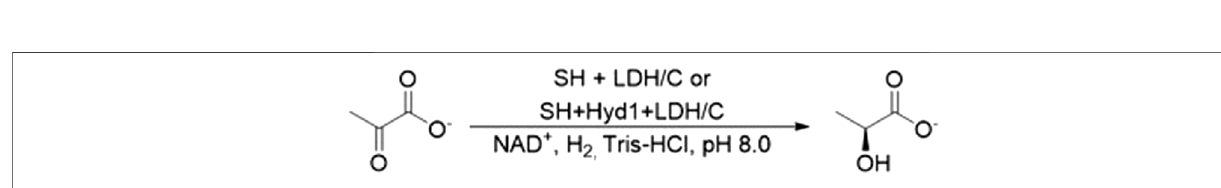
FIGURE 6 | NADH generation by SH/C or SH + Hyd1/C under continuous fl ow hydrogenation conditions. The left y axis shows the cumulative amount of product formed, and the right y axis shows the TTN of the NAD + reductase module of the SH. (A) Lifetime performance of SH/C [SH (0.18 mg), activated charcoal (20 mg)] vs. SH + Hyd1/C [SH (0.18 mg), Hyd1 (0.2 mg), activated charcoal (20 mg)] for the conversion of NAD + to NADH in the hydrogenation fl ow reactor. Reaction conditions: NAD + (5 mM), Tris-HCl buffer (50 mM, pH 8.0), 30 ° C, liquid fl ow rate (cid:1) 0.05 ml min − 1 , H 2 fl ow rate (cid:1) 0.6 ml min − 1 , t Res (cid:1) 18 s, reactor volume (cid:1) 0.2 ml. (B) The effect of temperature on the lifetime performance of SH + Hyd1/C [SH (0.18 mg), Hyd1 (0.2 mg), activated charcoal (20 mg)] for the conversion of NAD + to NADH in the fl ow reactor. Reaction conditions: NAD + (5 mM), Tris-HCl buffer (50 mM, pH 8.0), liquid fl ow rate (cid:1) 0.1 ml min − 1 , H volume (cid:1) 0.2 ml).